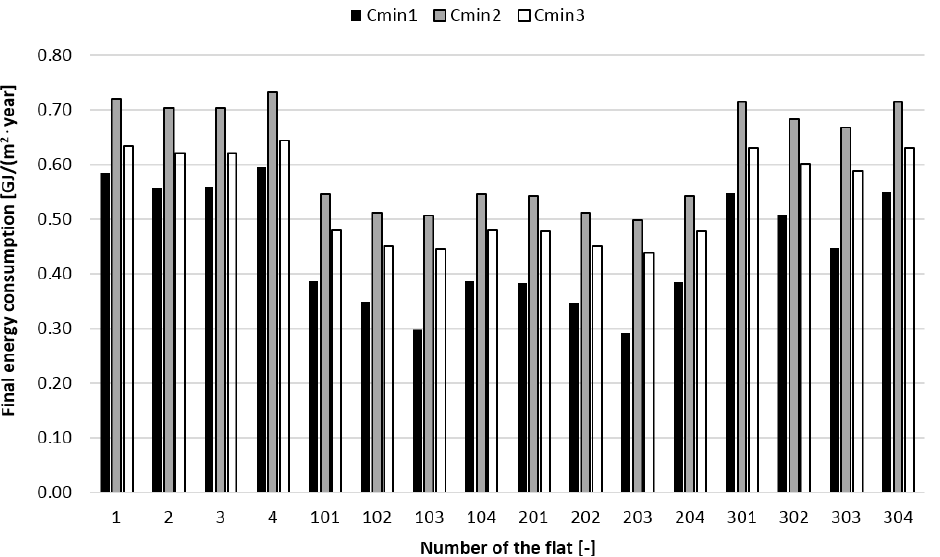
Figure 3. Unit minimum final energy consumption in the individual apartments of the studied building before thermorenovation for analyzed methods.